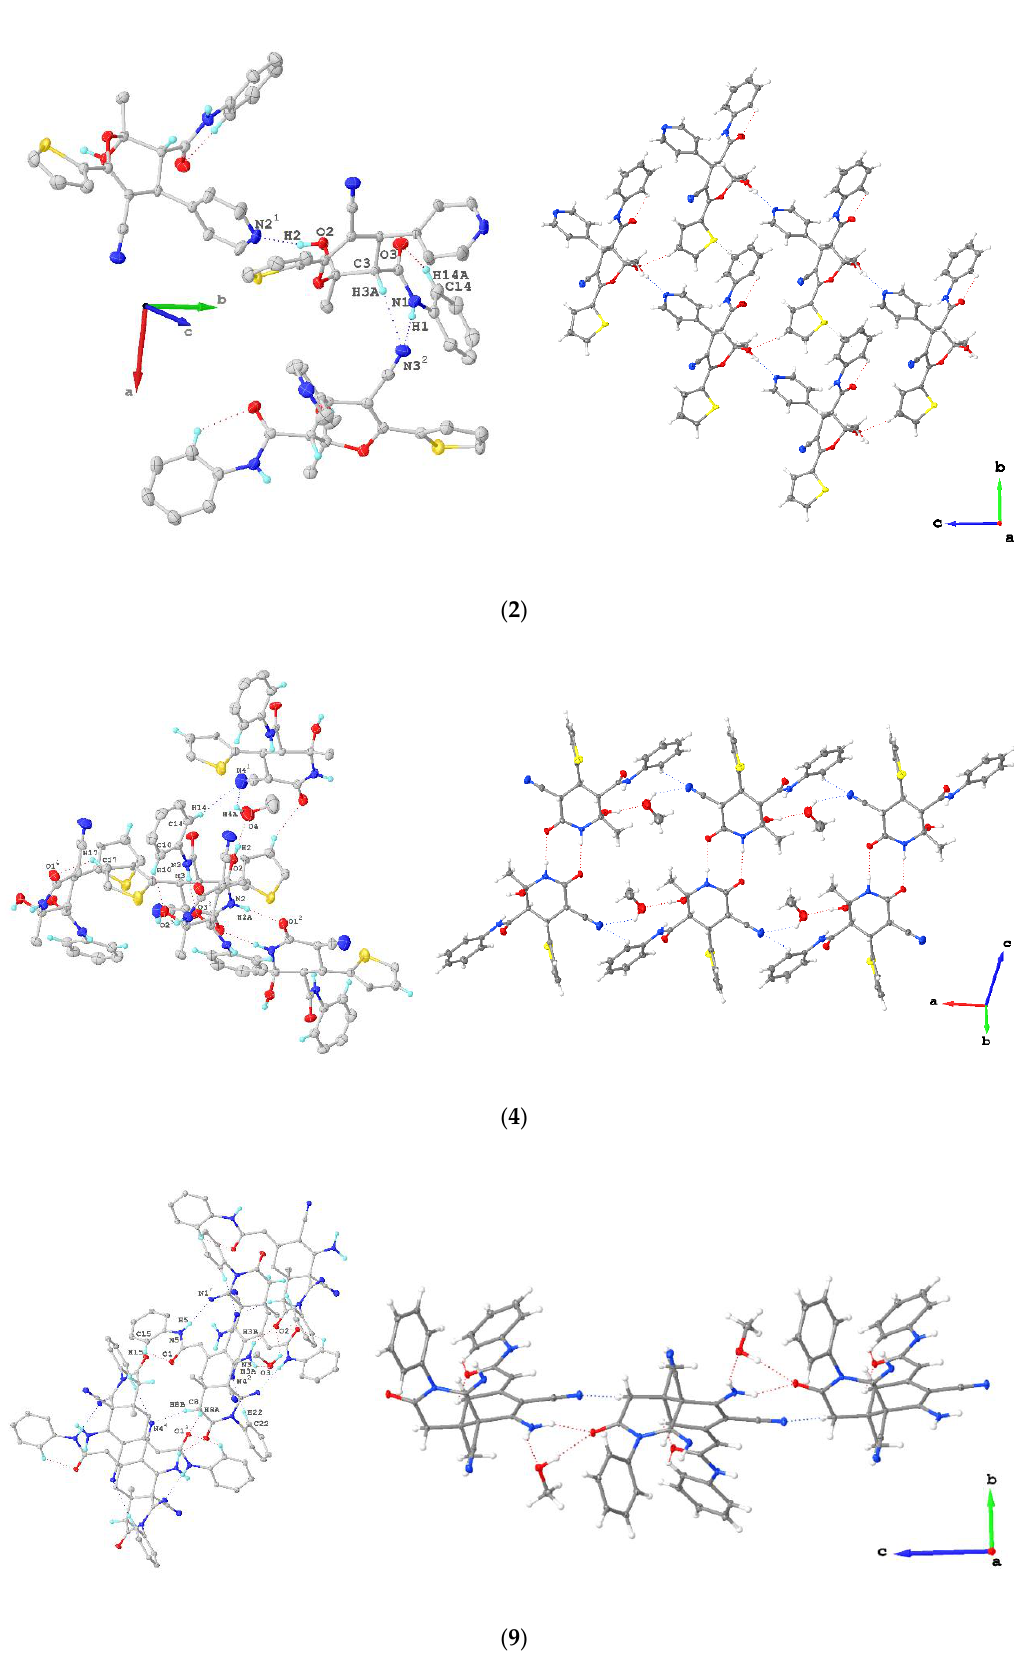
Figure 2. Intermolecular interactions observed in compounds 2 , 4 and 9 .